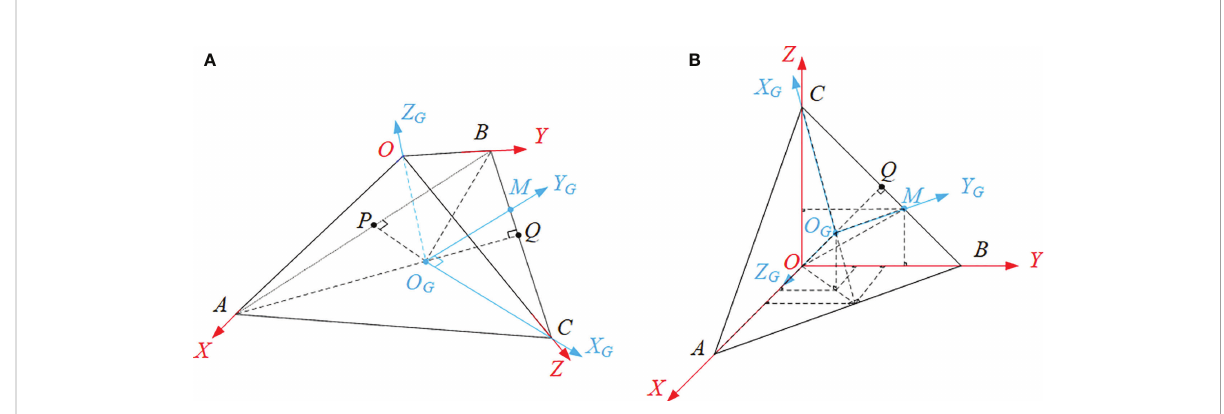
FIGURE 3 The coordinate systems, including the Sensing Coordinate System (marked by red), O - XYZ , and the Ground Coordinate System (marked by blue), O G - X G Y G Z G , where (A) is the standard view of the coordinate systems whilst (B) is the oblique axonometric drawing for the convenience of